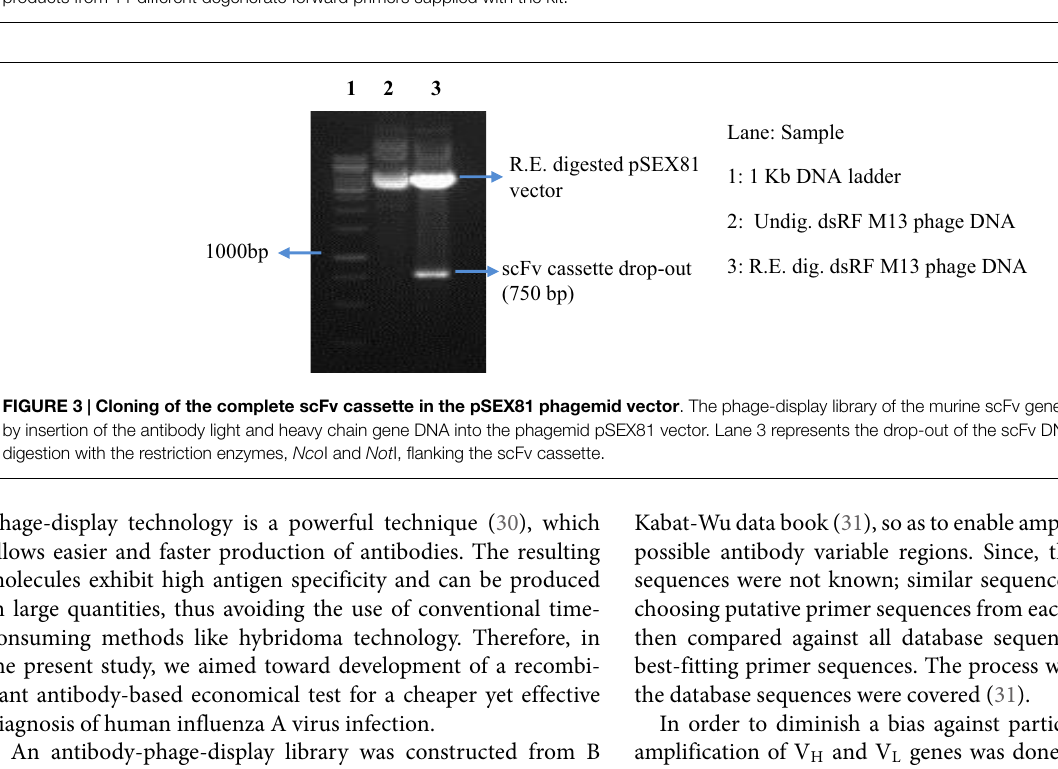
FIGURE 2 | Amplified light chain DNA (~380bp) (B) and heavy chain DNA (400bp) (A) using mouse IgG library primer set . Lanes 1–11 represent PCR products from 11 different degenerate forward primers supplied with the kit.